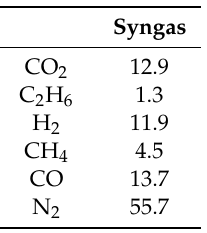
Table 2. Syngas compositions (%vol dry )